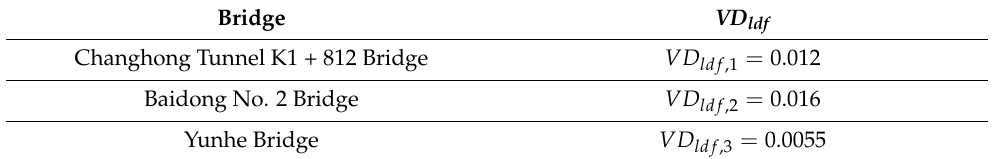
Table 7. VD ldf of Changhong Tunnel K1 + 812 Bridge, Baidong No. 2 Bridge, and Yunhe